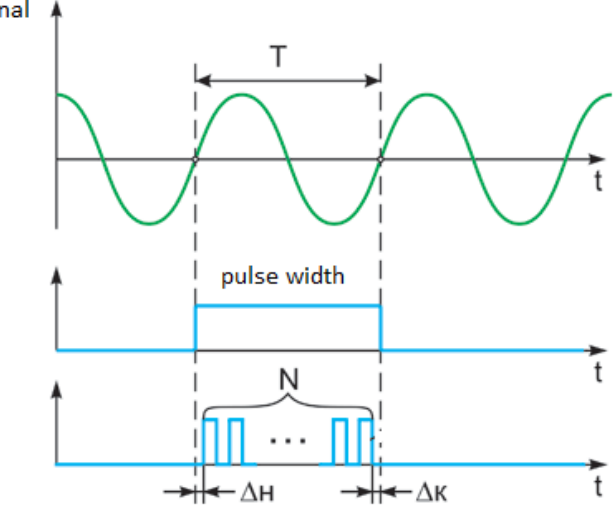
Figure 7. Pulse width method for measuring the period of a signal.